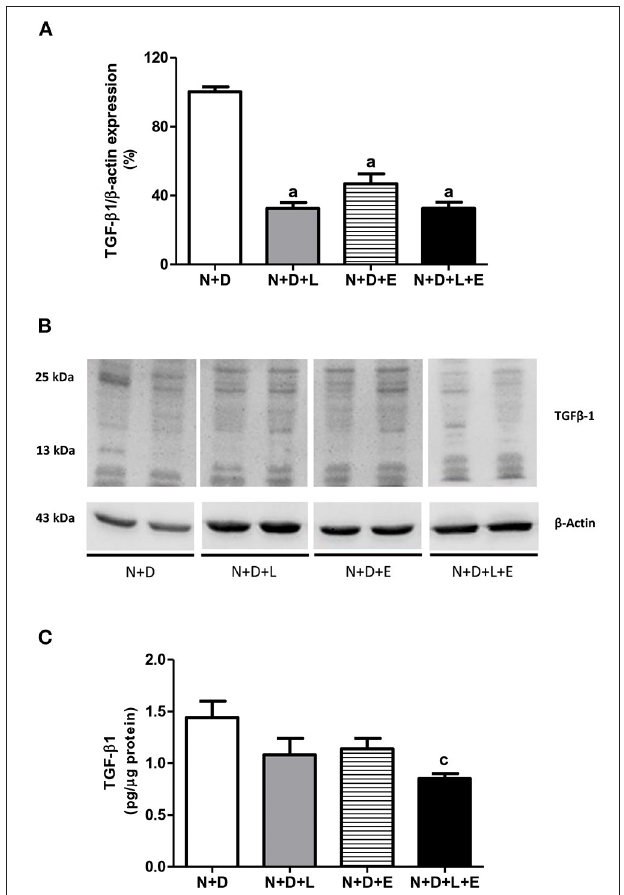
FIGURE 2 | Assessment of transforming growth factor- β 1 (TGF- β 1) amounts in the renal cortex evaluated 60 days after 5/6 nephrectomy in vitamin D-deficient rats treated with losartan, erlotinib or losartan + erlotinib. (A) Semiquantitative immunoblotting for TGF- β 1 with respective densitometric analysis of samples from N + D, N + D + L, N + D + E, and N + D + L + E groups. (B) Representative immunoblots which reacted with anti-TGF- β 1 revealing both 13 and 25 kDa bands. (C) Quantitative amount of TGF- β 1 evaluated by ELISA in the N + D, N + D + L, N + D + E, and N + D + L + E groups. Data are mean ± SEM. a p < 0.001, c p < 0.05 vs. N + D. N, 5/6-nephrectomized rats; D, vitamin D-deficient rats; L, losartan-treated rats; E, erlotinib-treated rats; L + E, rats